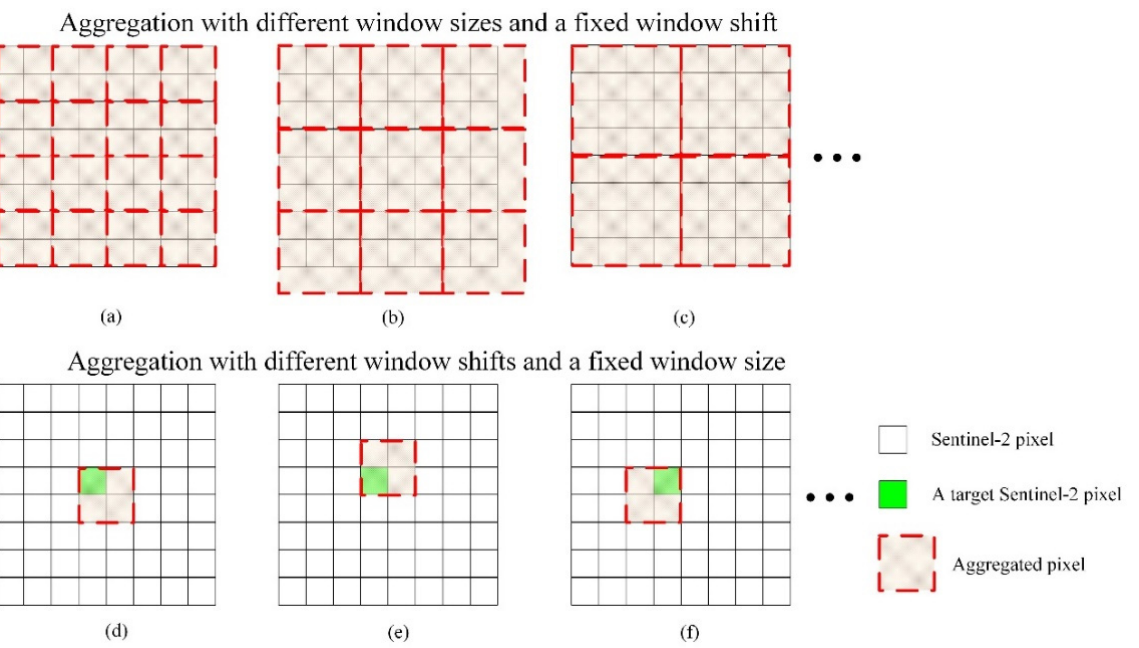
Figure 1. Pixel-level representation of the aggregation with different window sizes and window shifts to produce coarse pixel samples used for the surface water regression model. ( a – c ) Aggregation with different window sizes and the fixed window shift and ( d – f ) aggregation with different window shifts and the fixed window size.